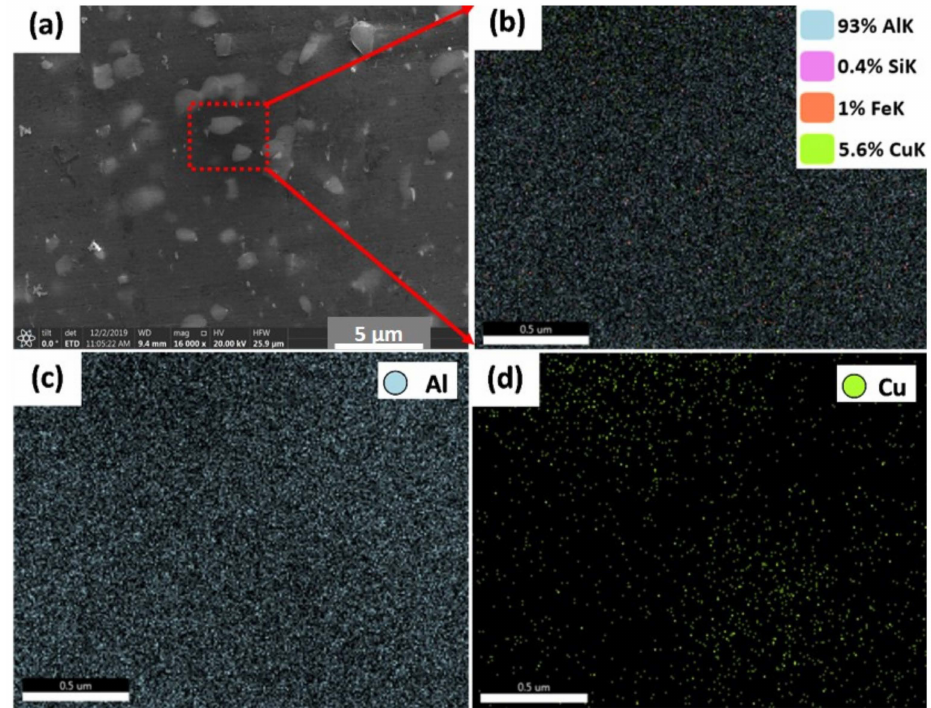
Figure 10. Elemental map distribution of AA2011-T6 AMPs produced at 1200 rpm and 6 mm/min: ( a ) SEM of AMPs, ( b ) map distribution of all alloying elements, and ( c , d ) map distribution of Al and Cu, respectively.